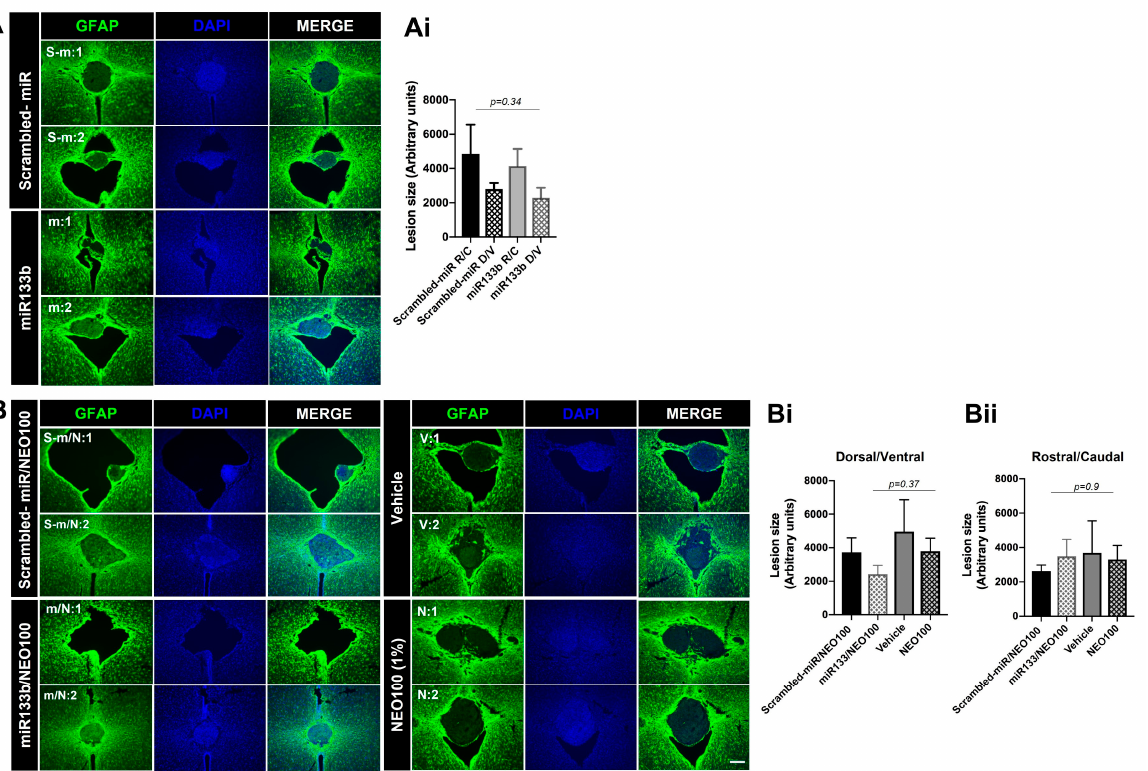
Figure 9. The effect of intranasal delivery of miR133b/Ago2 alone or in combination with 1% NEO100 on the lesion size at 56 days post-injury. Panels ( A , B ) show representative images of the spinal cord sections immunolabeled with GFAP for lesion identification. Sections were collected from two different mice per group, as follows: s − m:1 and s − m:2 from scrambled − miR group; m:1 and m:2 from miR133b/Ago2 group; s − m/N:1 and s − m/N:2 from scrambled − miR/NEO100; m/N:1 and m/N:2 from miR133b/Ago2/NEO100 group; v:1 and v:2 from vehicle and N:1 and N:2 from NEO100 group. Panels ( Ai , Bi , Bii ) represent the fluorescence quantification of the lesion size. One − way ANOVA with Tukey’s multiple comparison test. n = 4–5 sections per mouse, n = 3–5 mice per group. D/V = dorso-ventral (width) and R/C = rostro-caudal (height); scale bar: 100 µ